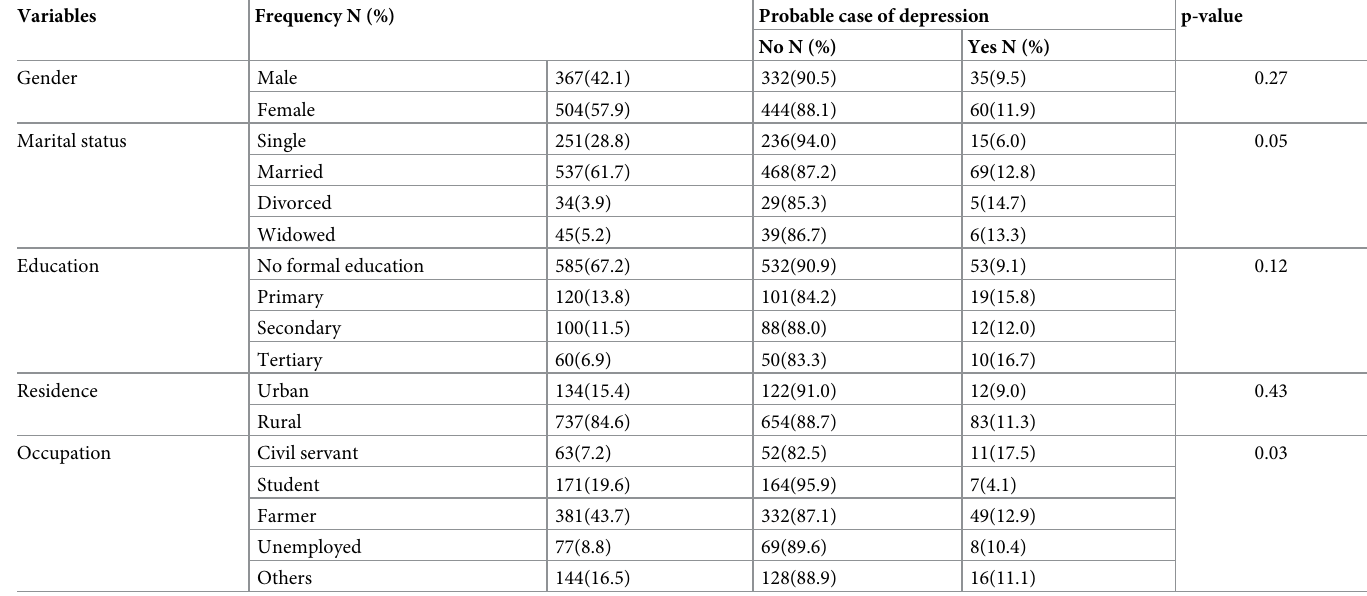
Table 1. Socio-demographic characteristics and probable case of depression among patients with dyspepsia in Ethiopia (n =